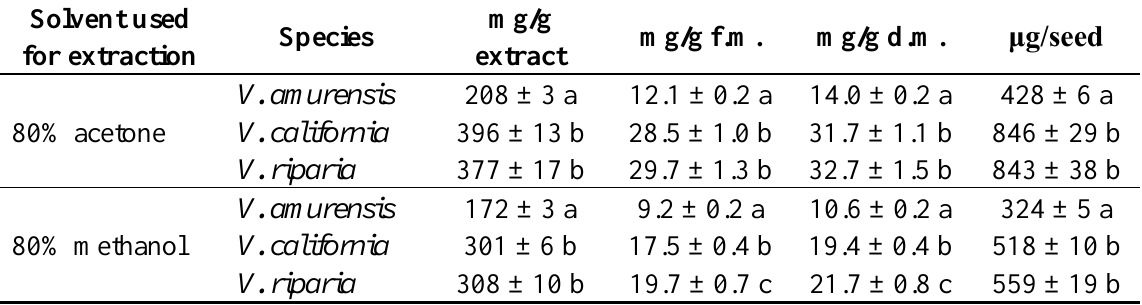
Table 1. Content of total phenolics in the extracts and seeds.